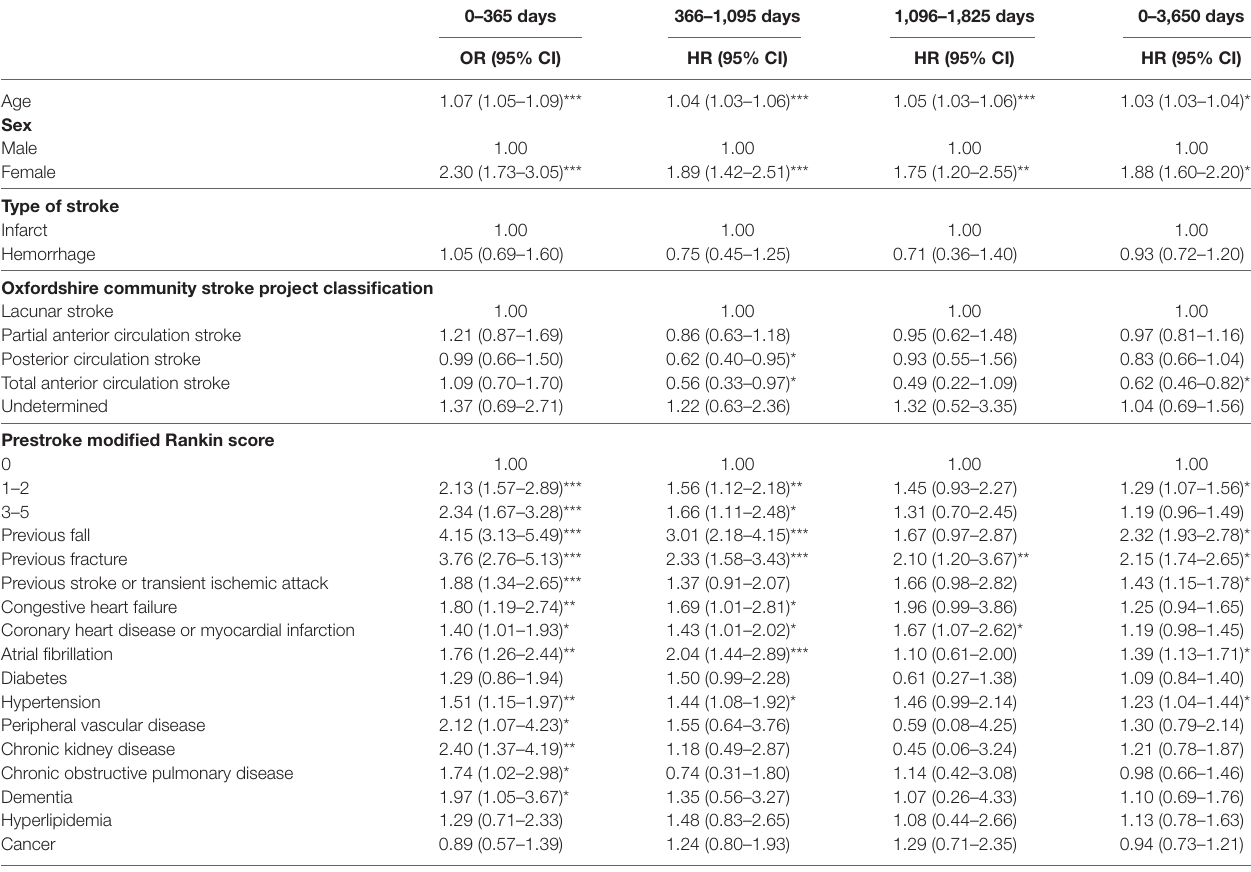
TaBle 4 | Univariate analysis of risk factors for poststroke fractures over time after